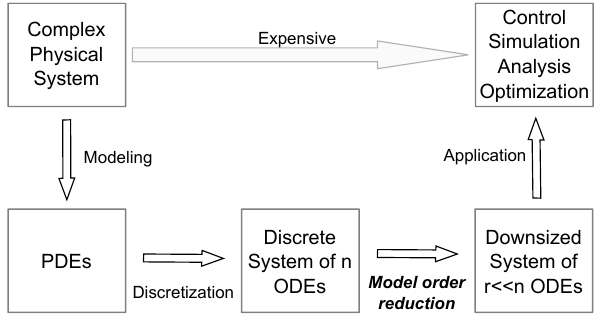
Figure 2. Classification of model order reduction in the simulation process of a dynamical